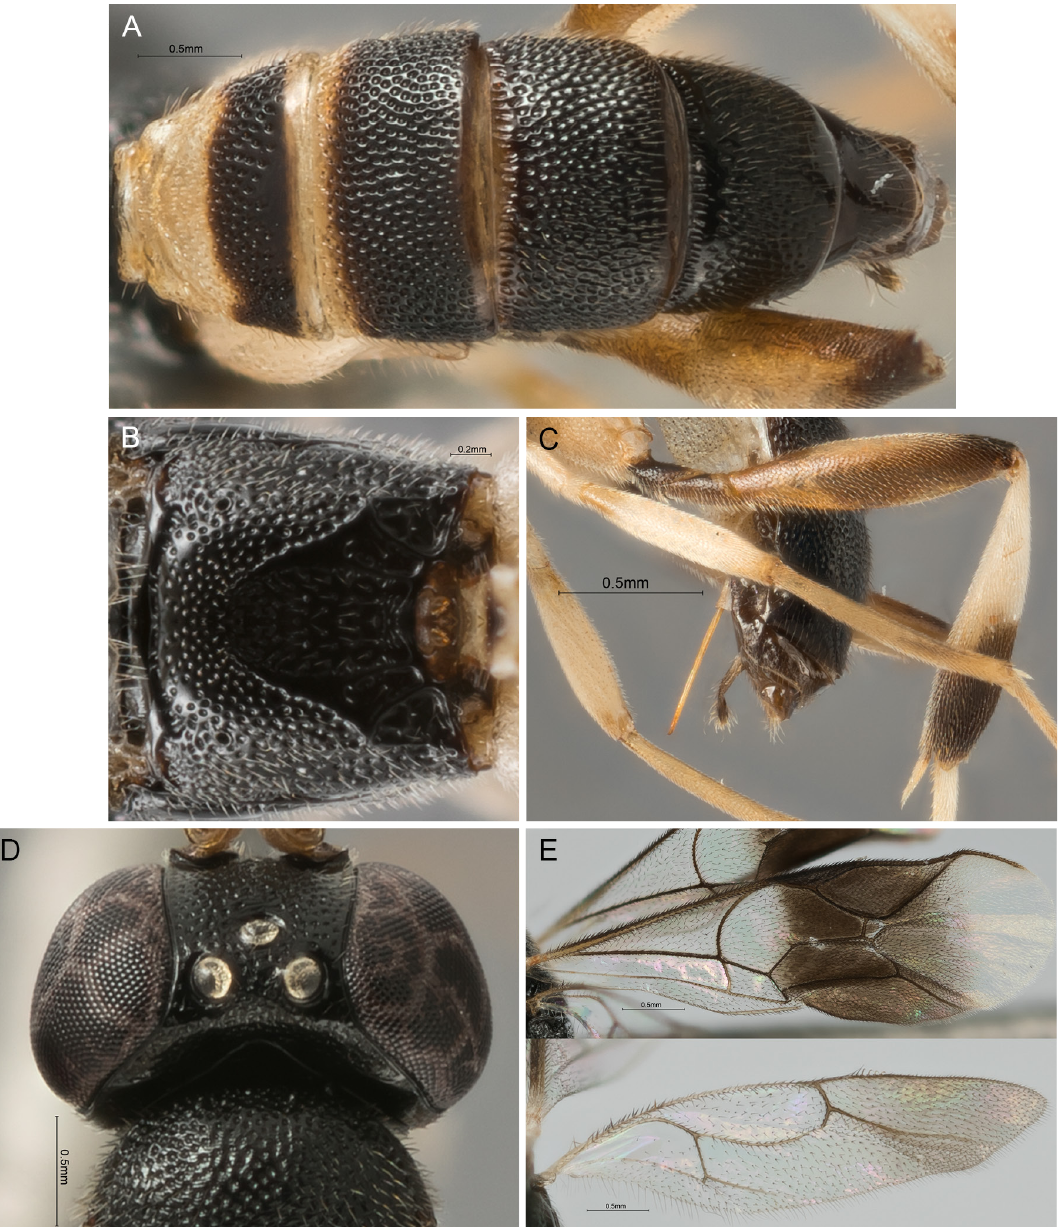
Fig. 12. Palpostilpnus mangrovi sp. nov., holotype, ♀ (LKCNHM). A . Metasoma, dorsal view. B . Propodeum, dorsal view. C . Ovipositor. D . Vertex. E .